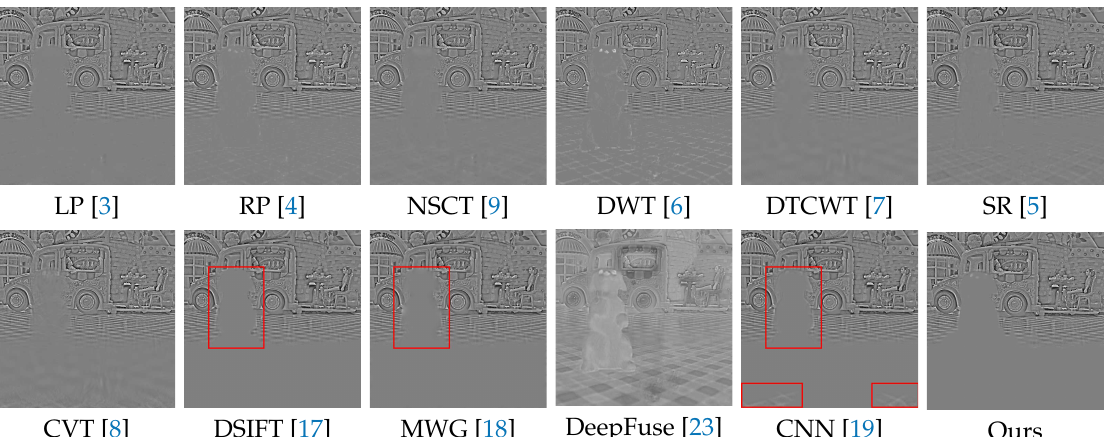
Figure 11. The difference images obtained by subtracting one source image from each fused image (see Figure 8).